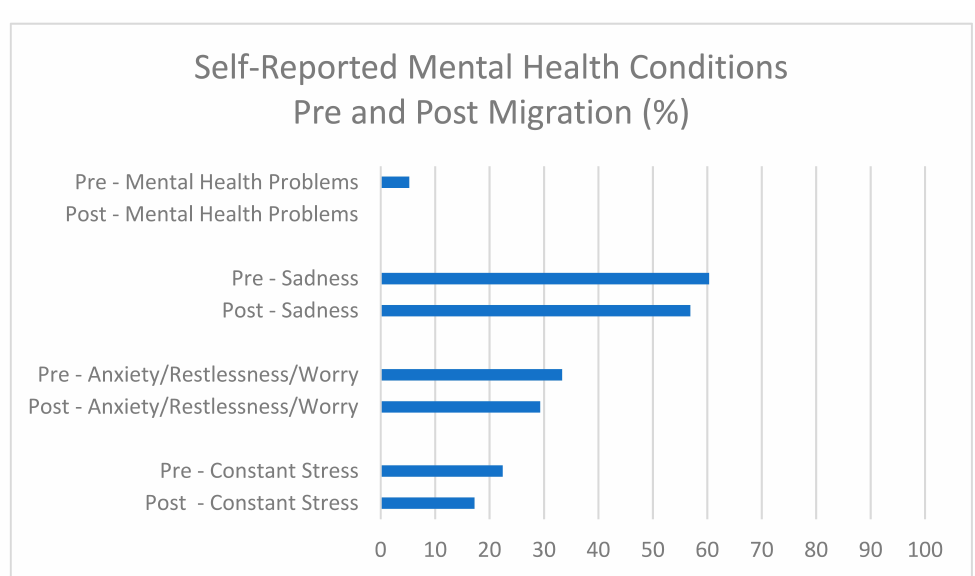
Figure 1. Self-reported mental health pre- and